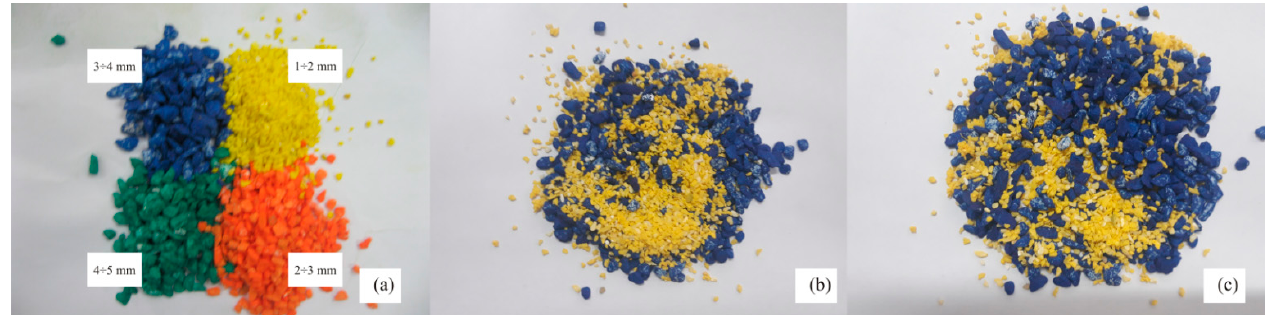
Figure 2. The blending material used for blending experiments ( a ), the blending conduct, (binary mixture of limestone particles, diameters 1 ÷ 2 and 3 ÷ 4 mm), after pre-mixing with three elements, ( b ), following the vertical static mixer equipped with five elements ( c